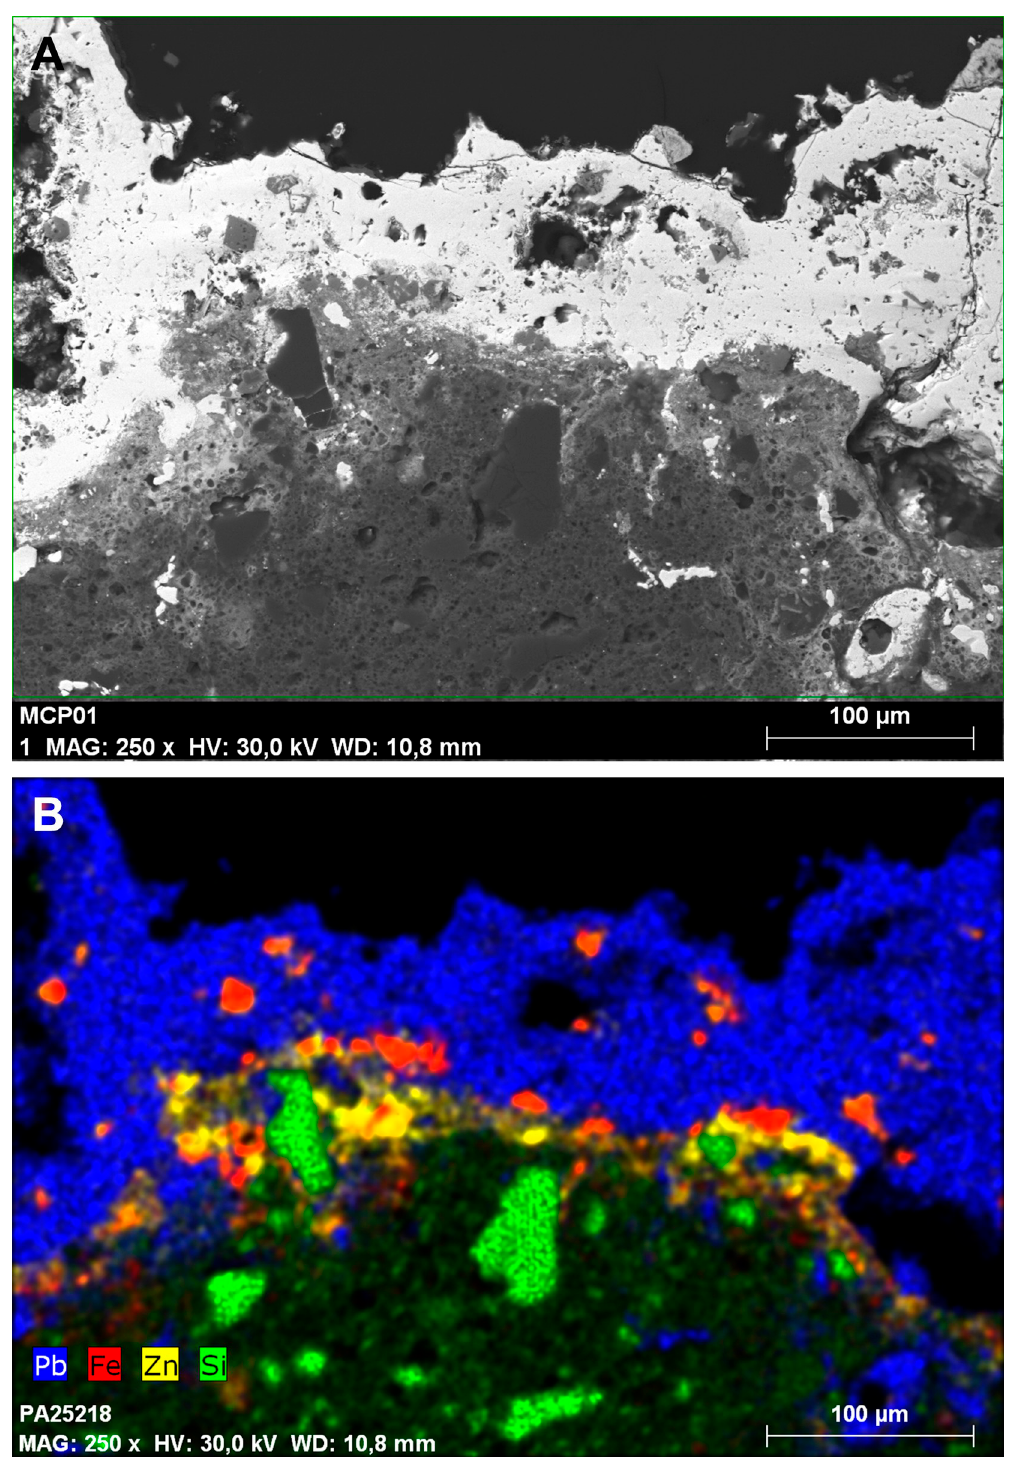
Fig 21. Section of the Bleje ş ti 1–1 sample (A) and distribution map of the elements Pb, Fe, Zn and Si (B). SEM image, backscattered electrons (S. Rovira).